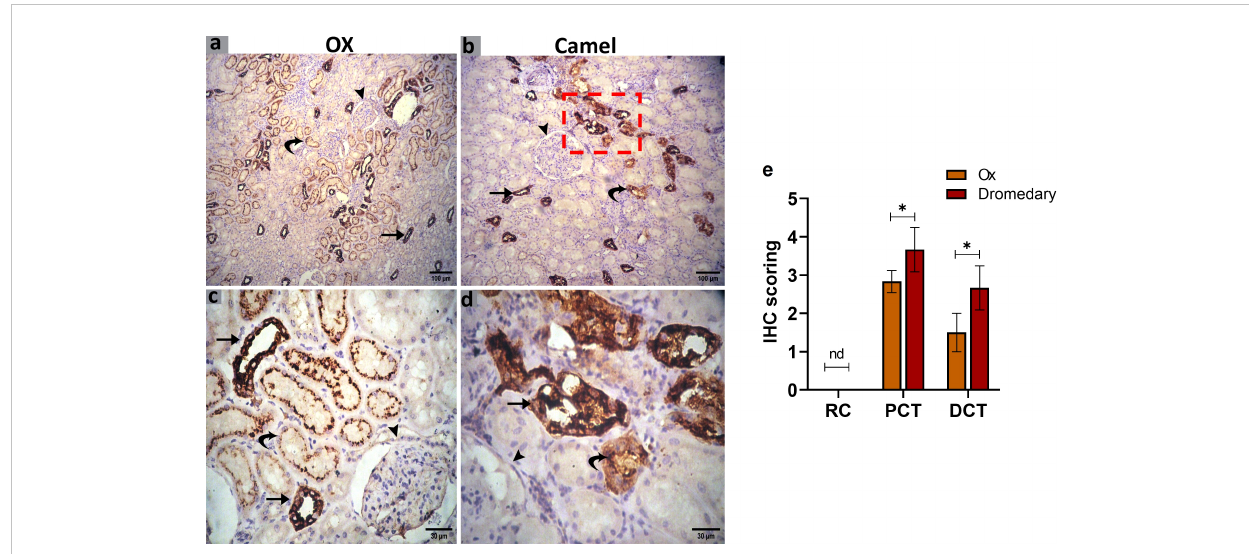
FIGURE 9 (A, C) Immunohistochemical analysis for AQP2 protein expression in the renal tissues of the oxen. A negative expression in the glomerulus (arrowhead), a mild expression in the distal convoluted tubules (DCT, curved arrow), and moderate expression in the proximal convoluted tubules (PCT, arrows) were noted. Scale bar, 100 m m and 30 m m. (B, D) Immunohistochemical analysis for AQP2 protein expression in the renal tissues of the dromedary kidney. A negative expression in glomeruli (arrowhead), moderate expression in the DCT (curved arrow), and a strong expression in the PCT (arrows) were detected. Scale bar, 100 m m and 30 m m. (E) Expression scoring for the expression of AQP2 along the nephron components in kidneys of oxen and dromedaries. A minimum of 3 slides were assessed for each species. Data shown are represented as mean ± SD.* p